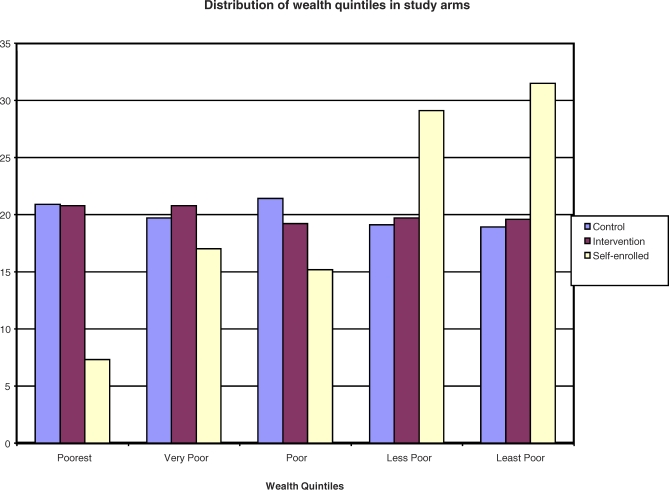
Distribution of Wealth Quintiles in Study Arms